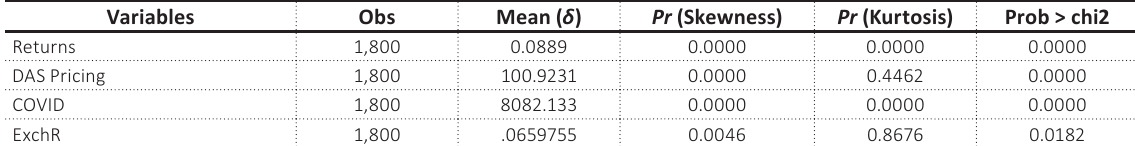
Table 3. Fixed effects result on the series: DAS pricing, COVID-19, exchange rate, and return on the